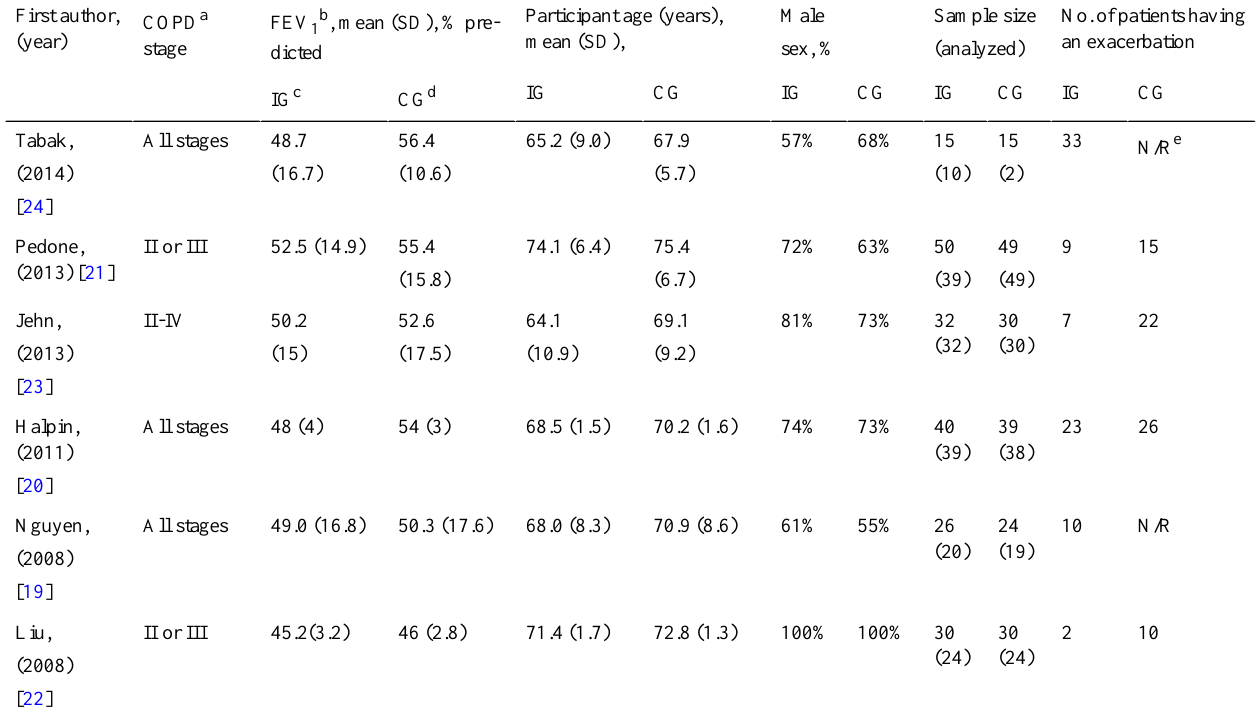
Table 2. Characteristics of studies using smartphone interventions with COPD patients.